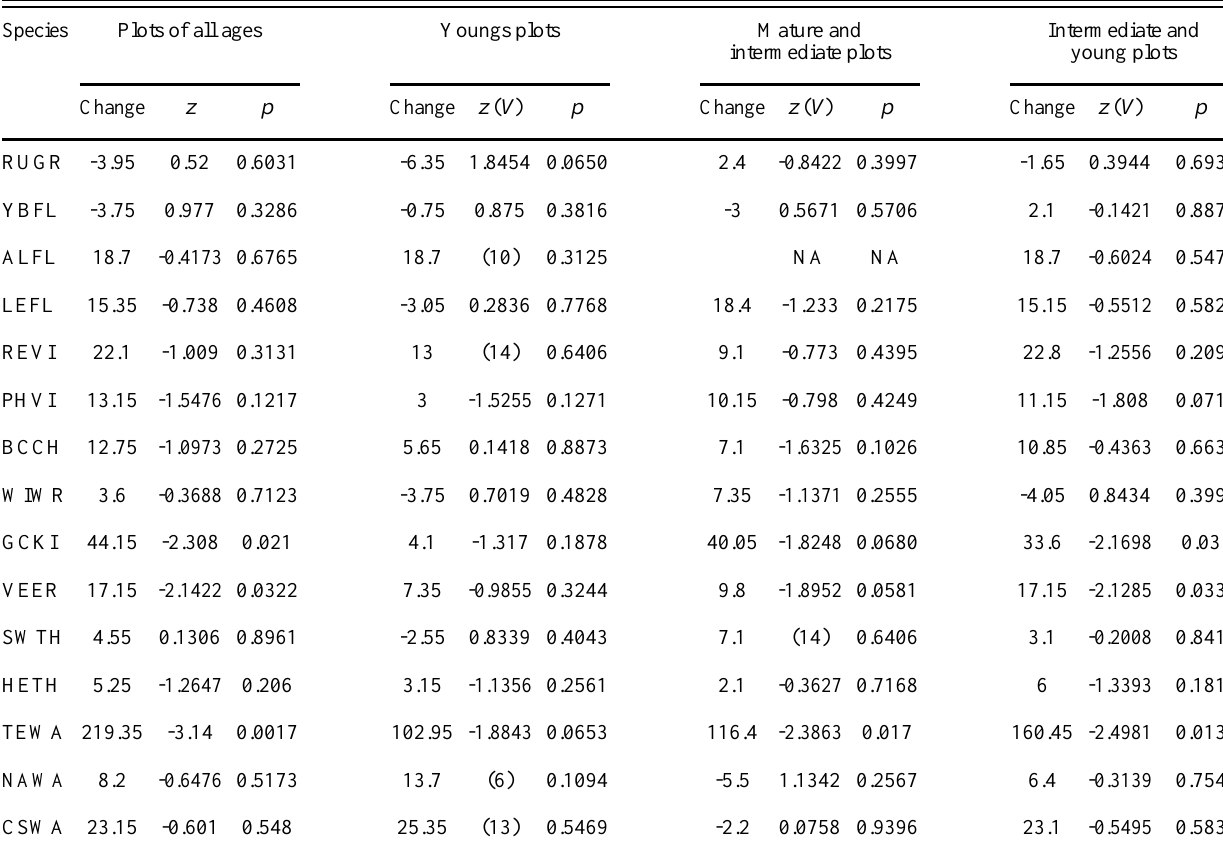
Table 1 . Change in number of territories from 1979 + 1980 to 1982 + 1983, and results of Wilcoxon signed- ranks test for paired data for the 30 most common species in the study plots. P -values less than 0.05 are highlighted in gray along with their associated species. For n > 25 or when there are ties, the normal approximation ( z ) of the test statistic is provided, otherwise the Wilcoxon signed-ranks test statistic V is provided. RUGR = Ruffled Grouse ( Bonasa umbellus ), YBFL = Yellow-bellied Flycatcher ( Empidonax flaviventris ), ALFL = Alder Flycatcher ( Empidonax alnorum ), LEFL = Least Flycatcher ( Empidonax minimus ), REVI = Red-eyed Vireo ( Vireo olivaceus ), PHVI = Philadephia Vireo ( Vireo philadelphicus